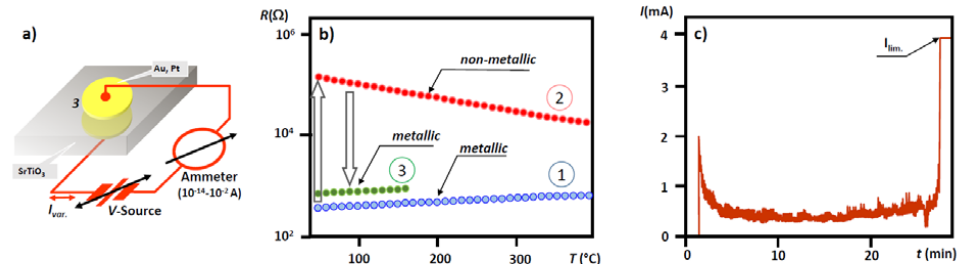
Figure 49. Insulator-to-metal transition and resistance switching in undoped SrTiO 3 single crystals. ( a ), Schematic of the reduction and electroreduction apparatus. ( b ), Measurements of the resistance versus temperature (1) crystal after thermal treatment at elevated temperatures under reducing conditions, indicating metallic behavior; (2) after re-oxidation under ambient conditions with an activation energy of 0.1 eV; and (3) after electroreduction at room temperatures under high-vacuum conditions in the constant-voltage mode ( V -source set at ± 100 V and the current flow, I var , limited to I = ± 4 mA), restoring metallic conductance. ( c ), Evolution of current for the final electroreduction process (from step 2 to step 3) in a sandwich metal–insulator–metal structure. The current initially shows classical dielectric relaxation with non-regular fluctuations superimposed on it and suddenly jumps to a current above the set current limit I lim , corresponding to the LRS with 800 Ω (adapted from [55]).